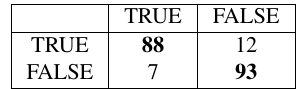
Table 1: Confusion matrix for segments corresponding to build- ing edges.